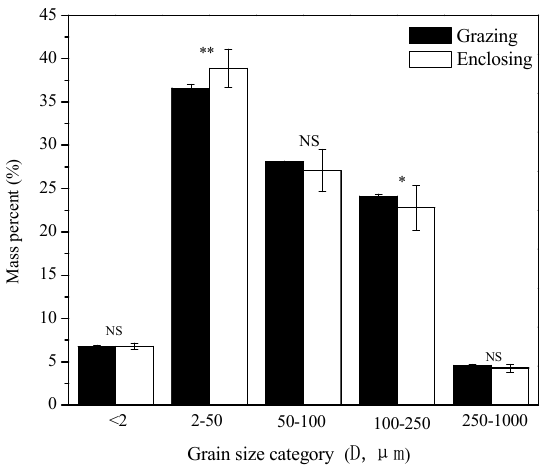
Figure 3. The mass percent in different size fractions of 0–10 cm soil of treatments. Note: * and ** show significant differences at p < 0.05 and p < 0.01 of each grain size category between two treatments, respectively, and NS shows no difference between two treatments ( t -test). Error bars are one standard deviation.